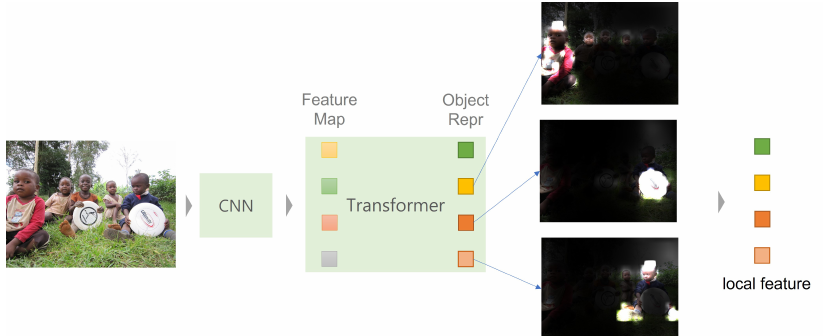
Figure 5. The visualization of weights of decoder. Each object query points to a different instance.